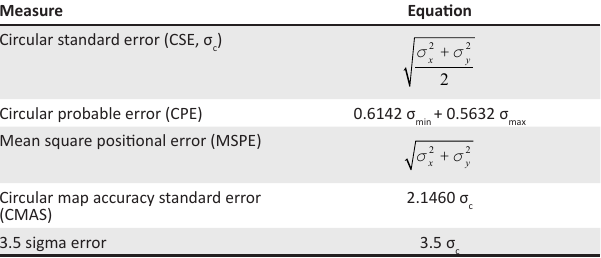
TABLE 1: Statistical measures used for the validation of the orthomosaics. Measure